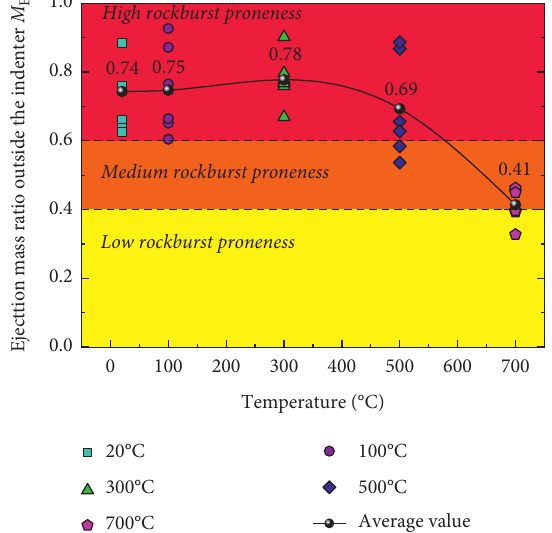
Figure 6: M E of pre-heated granite specimens under various temperatures